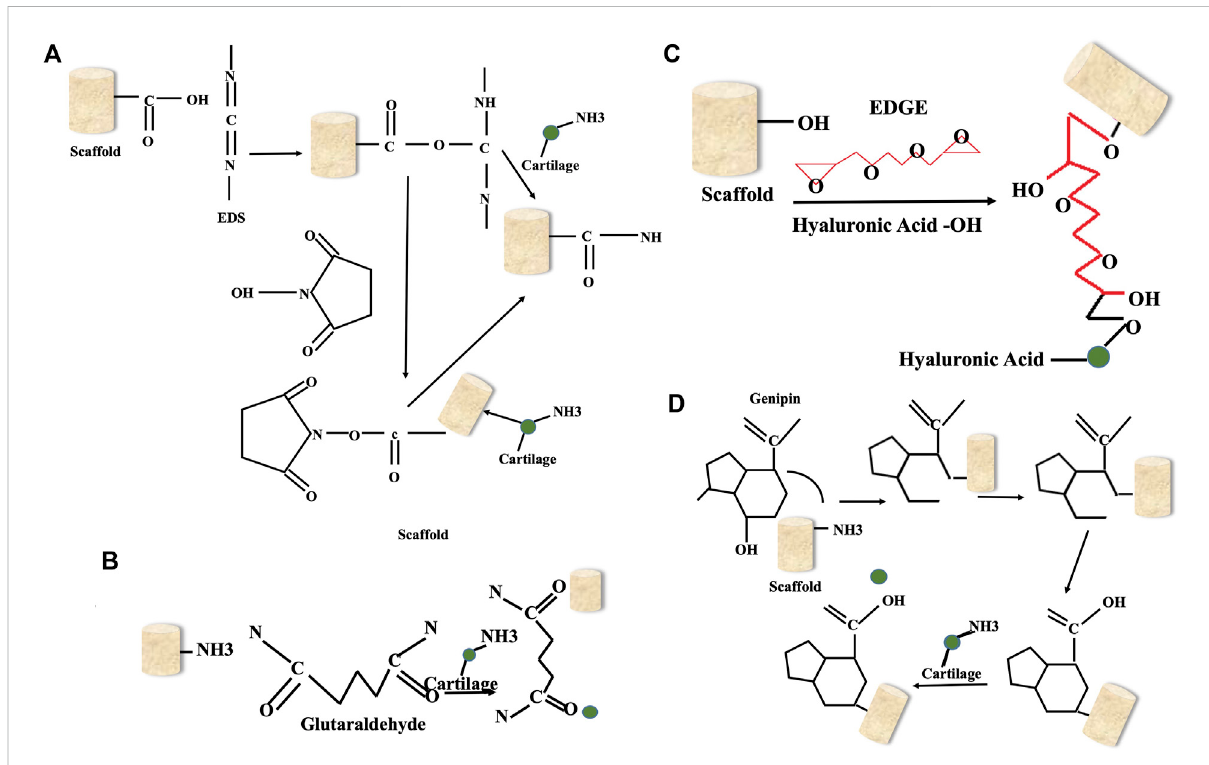
FIGURE 6 Different crosslinkers for bone tissue scaffolds: (A) EDC-NHS; (B) ; Glutaraldehyde; (C) EDGE; (D) Genipin.